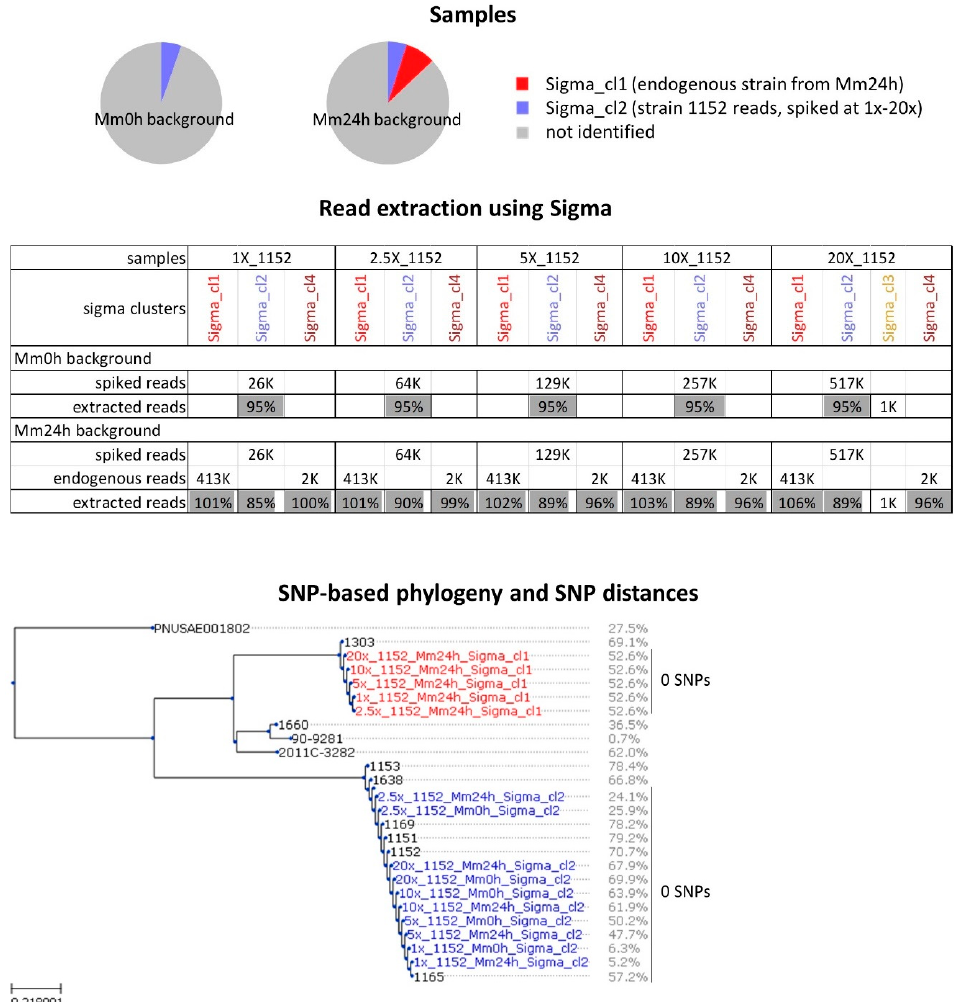
Figure 3. Strain-level analysis of in silico spiked metagenomic samples containing the strain TIAC1152 at di ff erent coverages. Samples: the pie plots represent schematically the simulated metagenomic samples consisting of isolate TIAC1152 reads down-sampled to di ff erent coverage and in silico spiked into the non-enriched minced meat sample containing no endogenous E. coli strains (Mm0h background) and the enriched minced meat sample containing one more prevalent and one negligible (not included in figure) endogenous E. coli strain according to Sigma (Mm24h background). Read extraction using Sigma: the number of isolate TIAC1152 reads surviving upon quality trimming spiked into the Mm0h and the Mm24h backgrounds (spiked reads), number of reads belonging to the endogenous strains from Mm24h according to Sigma (endogenous reads), and percentage of spiked and endogenous reads that were attributed by Sigma to clusters and extracted from the simulated metagenomic samples (extracted reads) are listed. For clusters containing in silico spiked reads, the percentage is calculated relative to the number of the in silico spiked reads. If the origin of the reads in a cluster is unclear, then the number of extracted reads is reported instead of a percentage. For clusters containing reads of the main endogenous strain from the Mm24h background, the percentage is calculated relative to the number of reads observed in the unspiked Mm24h sample. SNP-based phylogeny and SNP distances: SNP-based phylogeny of Sigma clusters detected in metagenomic samples and thus presumably corresponding to individual bacterial strains (colored) and some background isolates (black, Table 1) is shown. Percentages listed next to the Sigma cluster names and isolate names indicate the fraction of the reference genome that was suitable for the phylogenetic analysis. In addition, SNP distances (expressed as SNPs per million of genomic positions) observed within some of the groups of closely related strains and isolates are